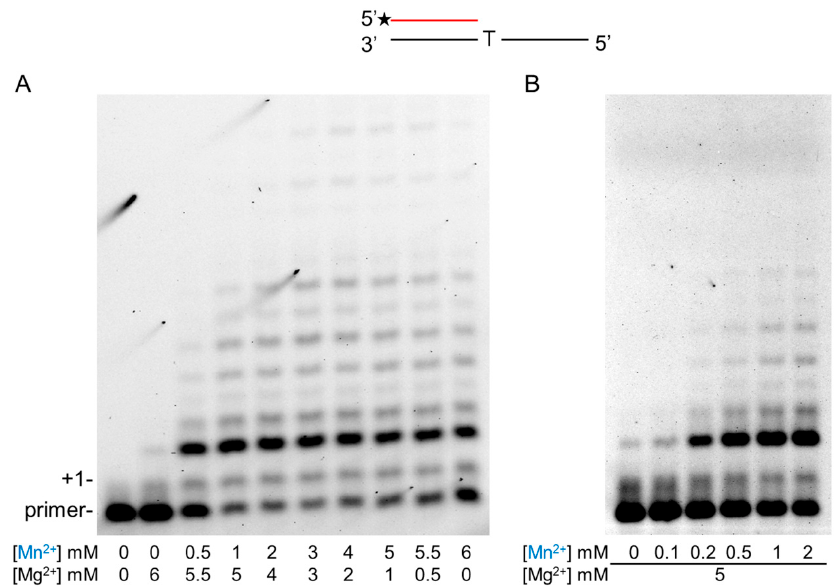
Figure 5. Metal ion preference of Pol η during RNA synthesis. Primer extension reactions were performed with 10-nM Pol η , 20-nM S6 RNA/DNA primer/template and 1-mM rNTP mix for 5 min. ( A ) Reactions contained both Mn 2+ and Mg 2+ in the indicated concentrations. ( B ) Reactions contained 5-mM Mg and the indicated concentrations of Mn 2+ . Manganese is highlighted in blue. The positions of the primer and its one nucleotide extension (+1) are indicated.